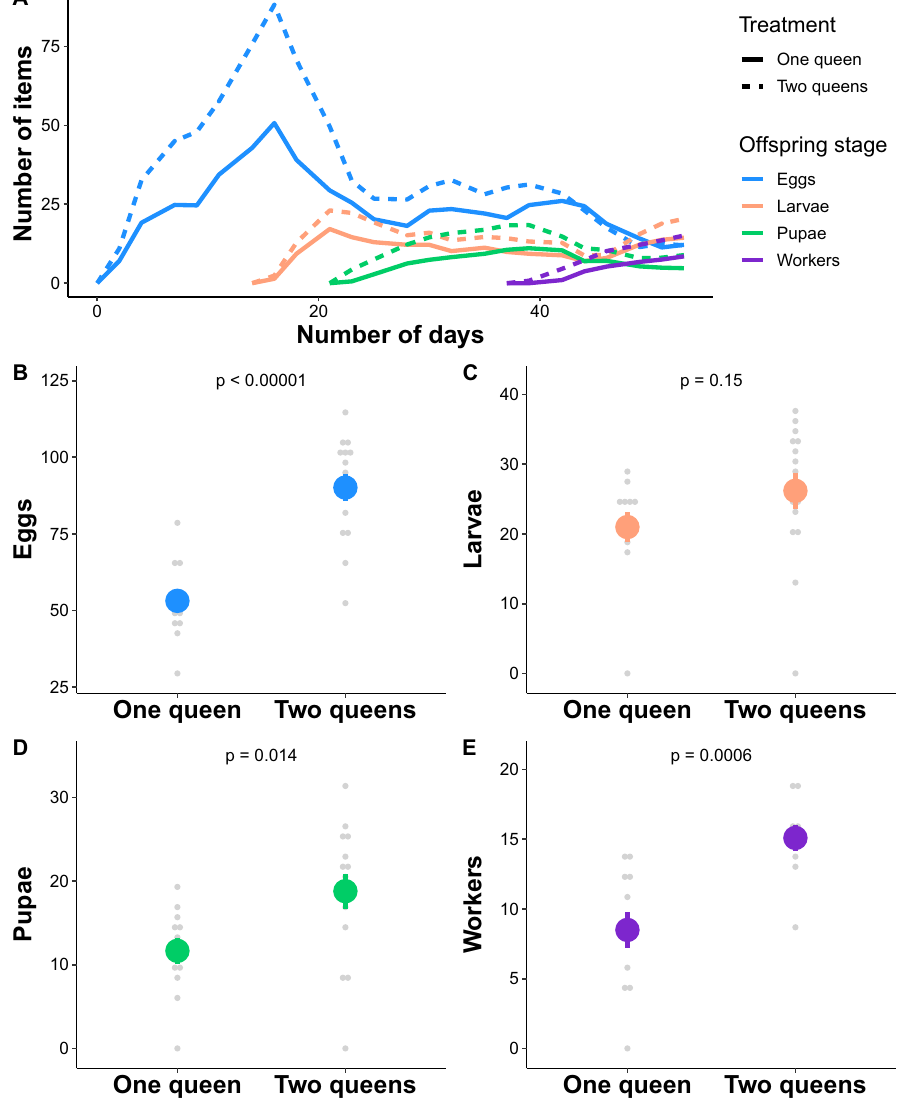
Figure 1. Effect of queen number on ( A ) mean offspring number over time since colony foundation (colors denote the brood type, while line type indicates treatment), maximum number of ( B ) eggs, ( C ) larvae, ( D ) pupae recorded in the colonies, and ( E ) number of workers at the end of the experiment (mean ± standard